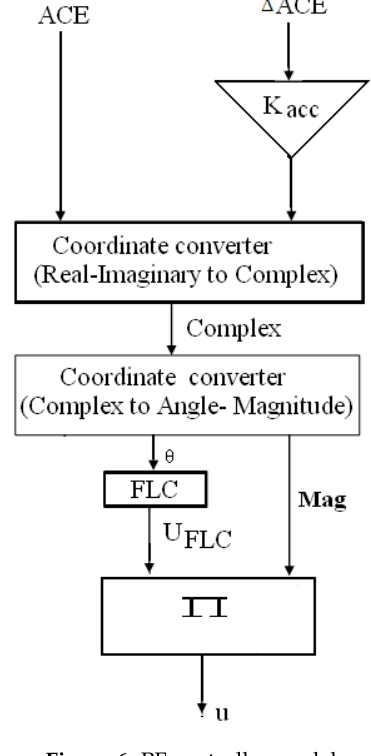
Figure 6. PF controller